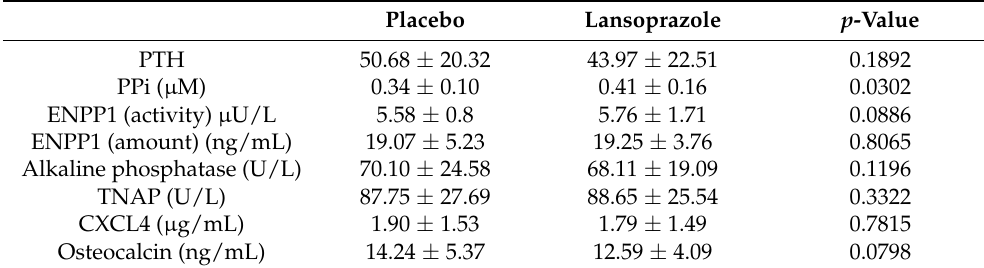
Table 2. Laboratory parameters in the final visits according to the phase of therapy. Placebo